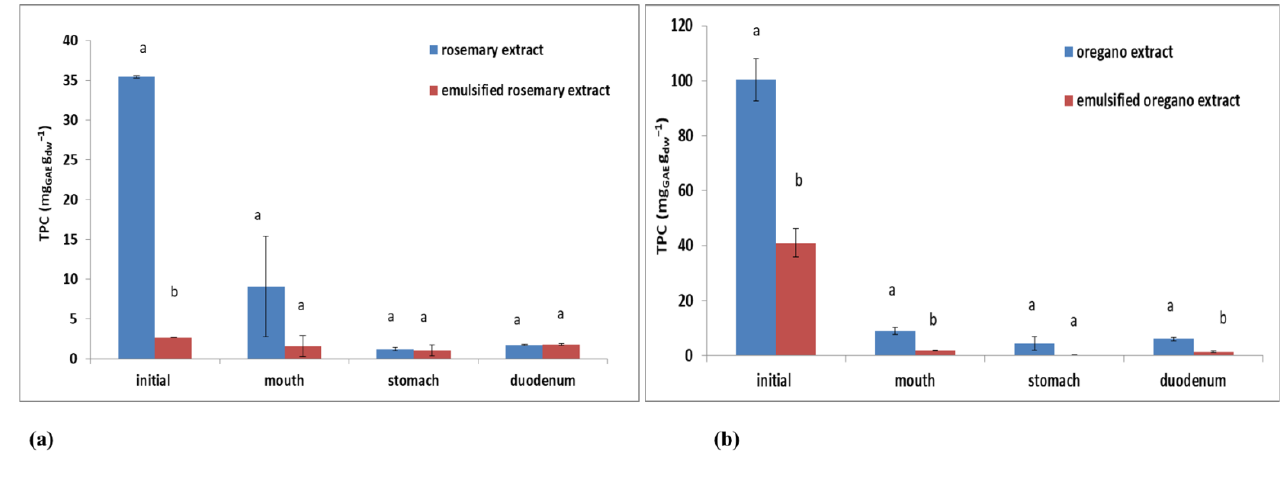
Figure 7. Changes in the total polyphenolic content (TPC) of plant extracts and oil-in-water emulsions containing extract during in vitro digestion for ( a ) rosemary and ( b ) oregano. Different letters above the columns represent significant differences at p < 0.05.